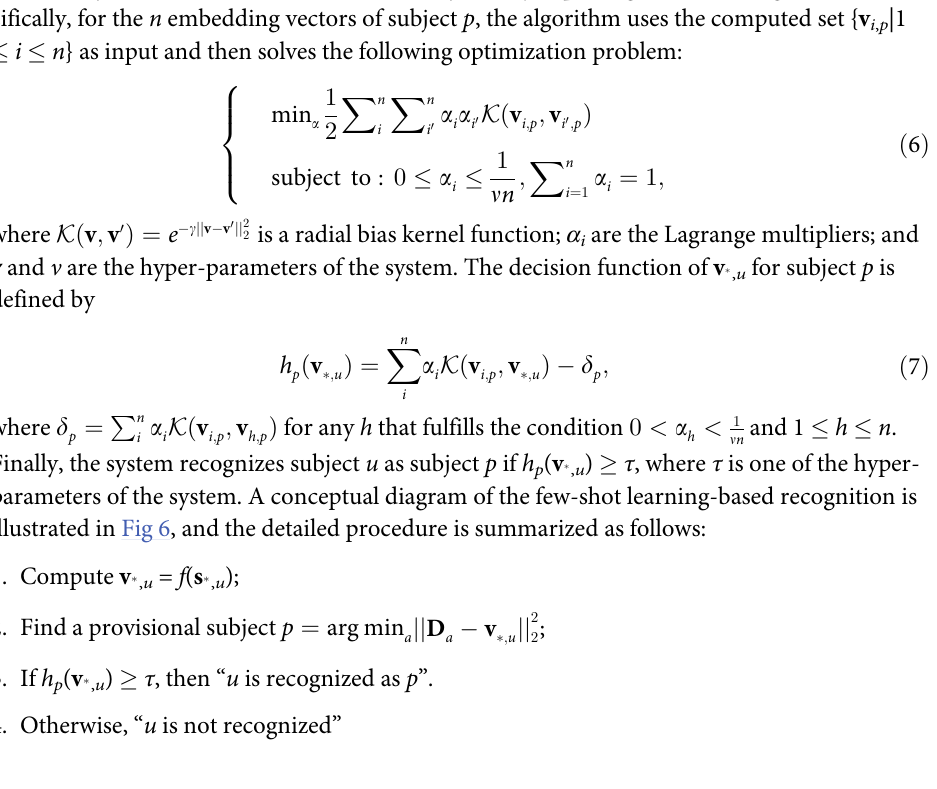
Fig 6. Illustration of gait recognition using the trained encoder. Here, unit step s � , s � , w is